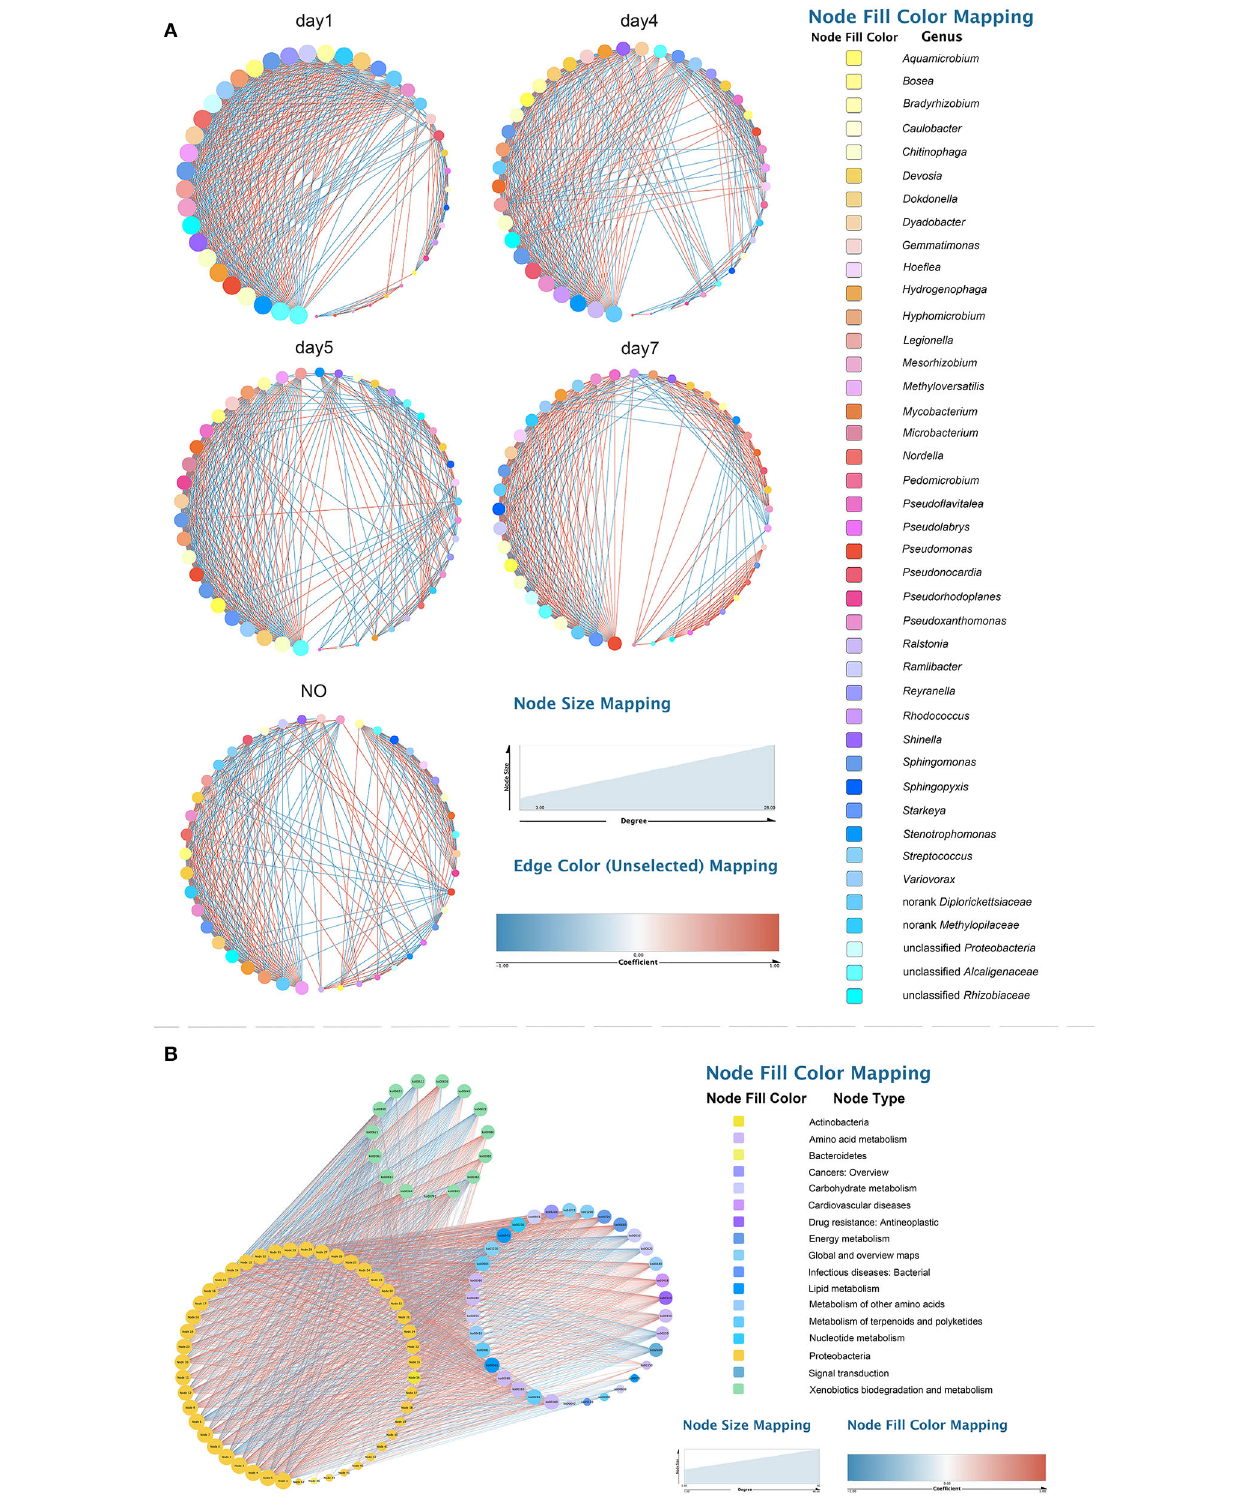
FIGURE 7 | Networks of the microbial consortium in different time points and incapable consortium (A) co-occurrence network analysis; (B) species/function correlation network. Node size is proportional to node degree. Node colors represent various phylogenetic genera. Red lines indicate positive interactions, and blue lines indicate negative